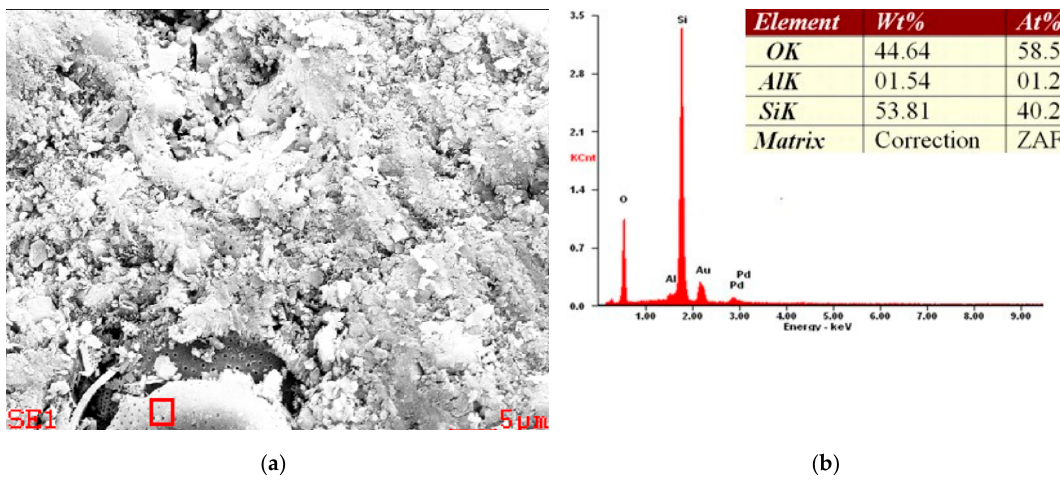
Figure 10. Example of SEM micrograph ( a ) and EDS spectra ( b ) of a diatomaceous earth sample from the Jawornik deposit. The sample was sputtered by an Au/Pd target.